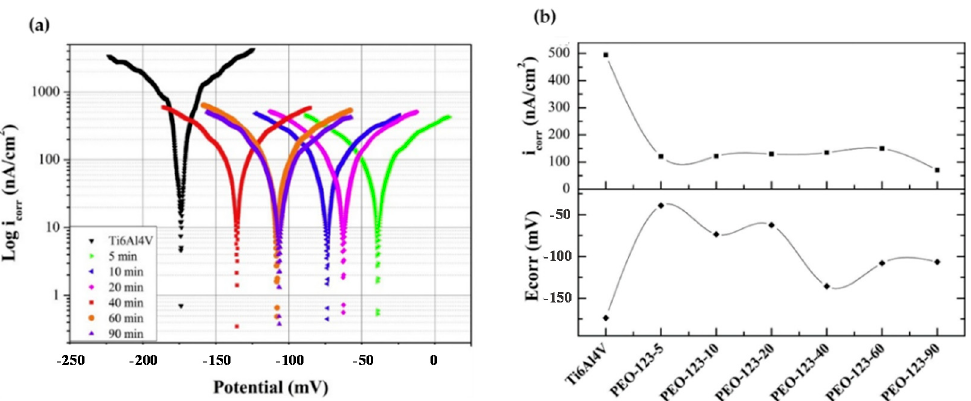
Figure 10. ( a ) The electrochemical polarization curves recorded in SBF solution at 36.5 °C for the PEO coatings at different deposition times and uncoated Ti-6Al-4V alloy. ( b ) The variations of the electrochemical parameters of uncoated Ti-6Al-4V alloy and the PEO coatings at different deposition times. ( a , b ) Reprinted from [128], copyright (2016), with permission from Elsevier.